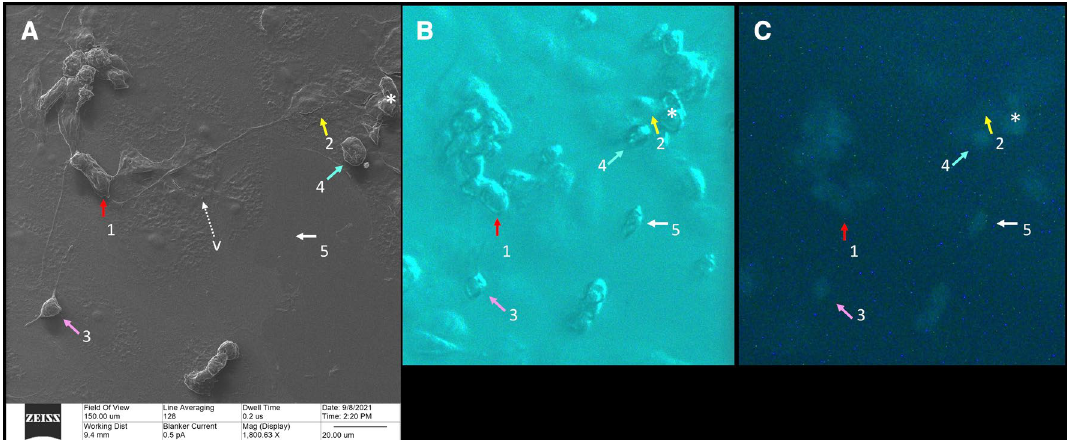
Figure 2. Correlative microscopy. A 150-micron square area has been imaged by HeIM ( A ), phase-contrast microscopy ( B ) and fluorescence microscopy ( C ). Our usual sequence of acquisition is to take a phase-contrast image first, then a fluorescence image, than a HeIM image, all on the same area. HeIM modality, by avoiding electroconductive coating, can allow changes in this sequence when needed. HeIM ( A ) and phase-contrast ( B ) modalities show the morphology of the cells. Fluorescence microscopy ( C ) highlights their infectious status, because only infected cells fluoresce in green. In this area, HeIM ( A ) shows that two cells (1 and 2) are connected by a TNT about 100 microns long. There is also a rounded bipolar cell (3) emitting TNT, and correlative microscopy shows that it is infected; this cell (3) did not change its position regarding the prior acquired phase-contrast photomicrograph. Rounded infected cells, however, tend to detach from the floor; correlation between Phase Contrast ( B ) and HeIM ( A ) shows that cell 4 changed its position slightly and cell 5 moved out of the field. Only HeIM was able to pick-up the presence of vesicles in the area; the tiny one indicated by “v” in ( A ) will be shown at higher magnification in Fig. 8D (HeIM ( A ) × 1800; Optical Microscopy ( B,C ) × 400).